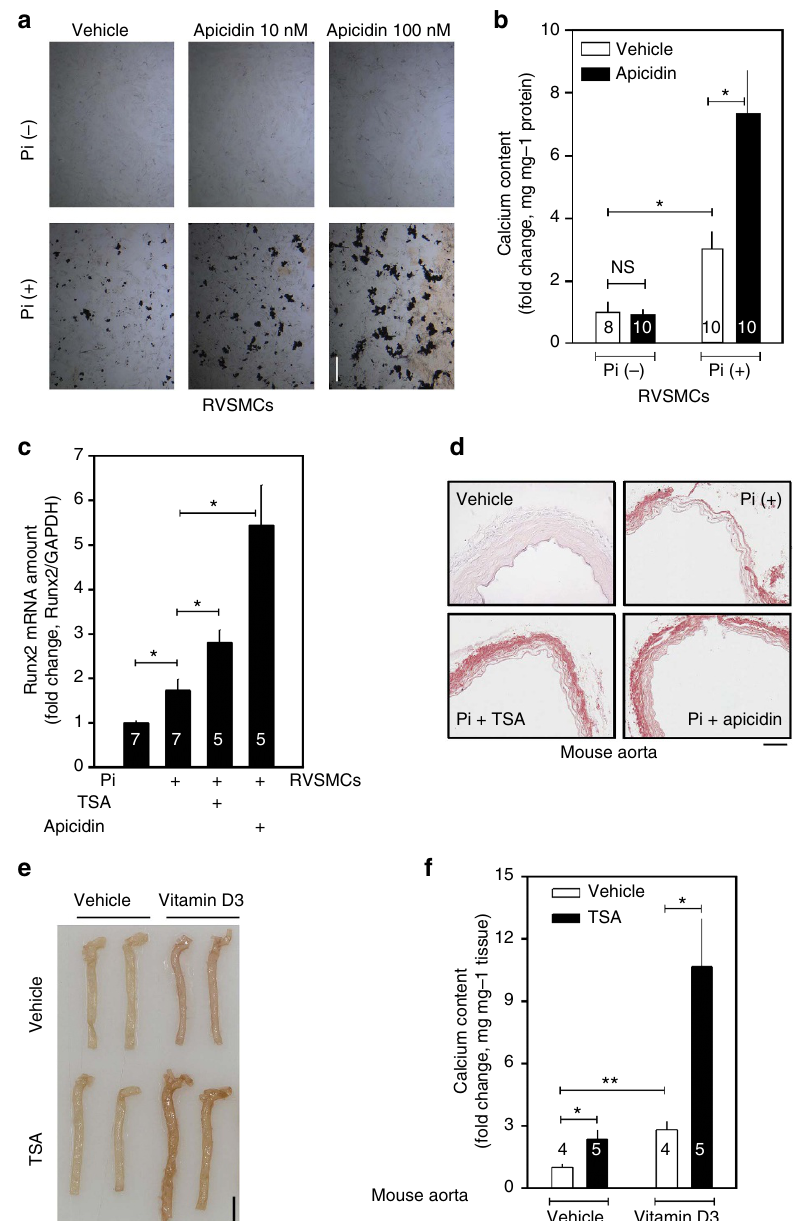
Figure 1 | HDAC inhibitors potentiate vascular calcification (VC). ( a ) Apicidin, a class-I-selective HDACi, potentiated the Pi-induced VC in a dose-dependent manner. VC was induced either by inorganic phosphate (Pi) in rat vascular smooth muscle cells (RVSMCs) or by vitamin D 3 (VD 3 ) in mouse. Scale bar, 100 m m. ( b ) Quantification results. Samples (8–10)were measured from three independent experimental sets. ( c ) Both 10nM TSA and 50nM apicidin potentiated Pi-induced induction of Runx2 . Quantitative real-time RT–PCR was performed. Each sample was measured in duplicate and counted as one case ( n ¼ 5–7 from two sets). ( d ) Induction of calcification of aorta ex vivo revealed enhancement of VC by Pi. Alizarin red S staining. Scale bar, 100 m m. ( e ) TSA (0.6mgkg (cid:2) 1 , intraperitoneally for 9 days) potentiated VC induced by VD 3 (5 (cid:3) 10 5 IUkg (cid:2) 1 per day, subcutaneous administered for the first 3 days). Calcification was determined with Alizarin red S staining. Scale bar, 3mm. ( f ) Quantification results of calcium content in the proximal aorta. Calcium contents from four to five mice in one experimental set were measured. Error bars represent s.e.m. * P o 0.05, ** P o 0.01, Numerals in bar graphs are the numbers of Fig. 3g) in the ligated mice compared with the non-ligation group even without apparent calcification stimuli 26 . Thus, we investi- (upper right panel). Quantification of the histological analysis is gated whether HDAC1 was also reduced in atherosclerosis- provided in Supplementary Fig. 3e. For further evaluation in a associated calcification without administration of VD 3 or calcium. human disease, calcified human coronary artery samples were used for HDAC1 immunohistochemistry. Compared with the atheromatous plaques as described previously 27 . Some of the mice ( B 30%) developed localized calcification (arrowheads in lower expression in coronary artery from normal patients, severe left panel in Fig. 3g), regardless of the severity of atheroma, and calcification reduced the expression of HDAC1 (Fig. 3h). HDAC1 expression was downregulated (lower right panel in The changes in the expression of HDAC1 are quantified in